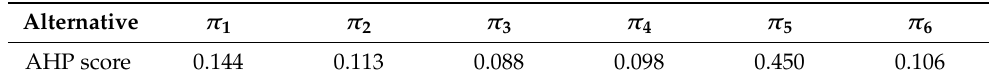
Table 3. The AHP scores of the alternative paths.